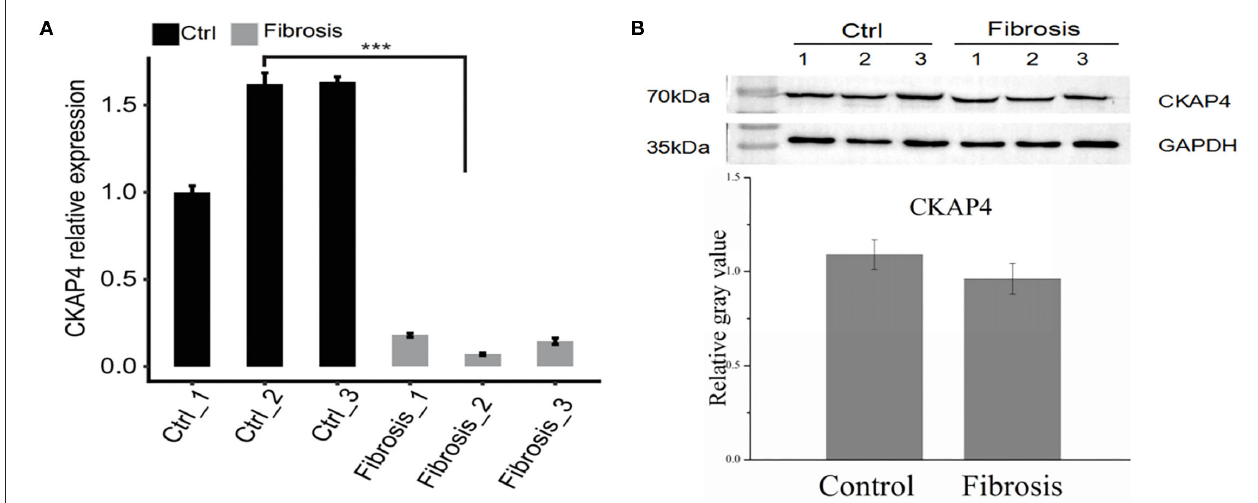
FIGURE 5 | CKAP4 expression is down-regulated in remodeling fibrotic myocardium. Quantitative PCR (A) and Western blotting (B) results indicated the mRNA and protein expression of CKAP4 in remodeling fibrotic myocardial samples ( n = 3) decreased significantly relative to control samples ( n = 3). *** P <